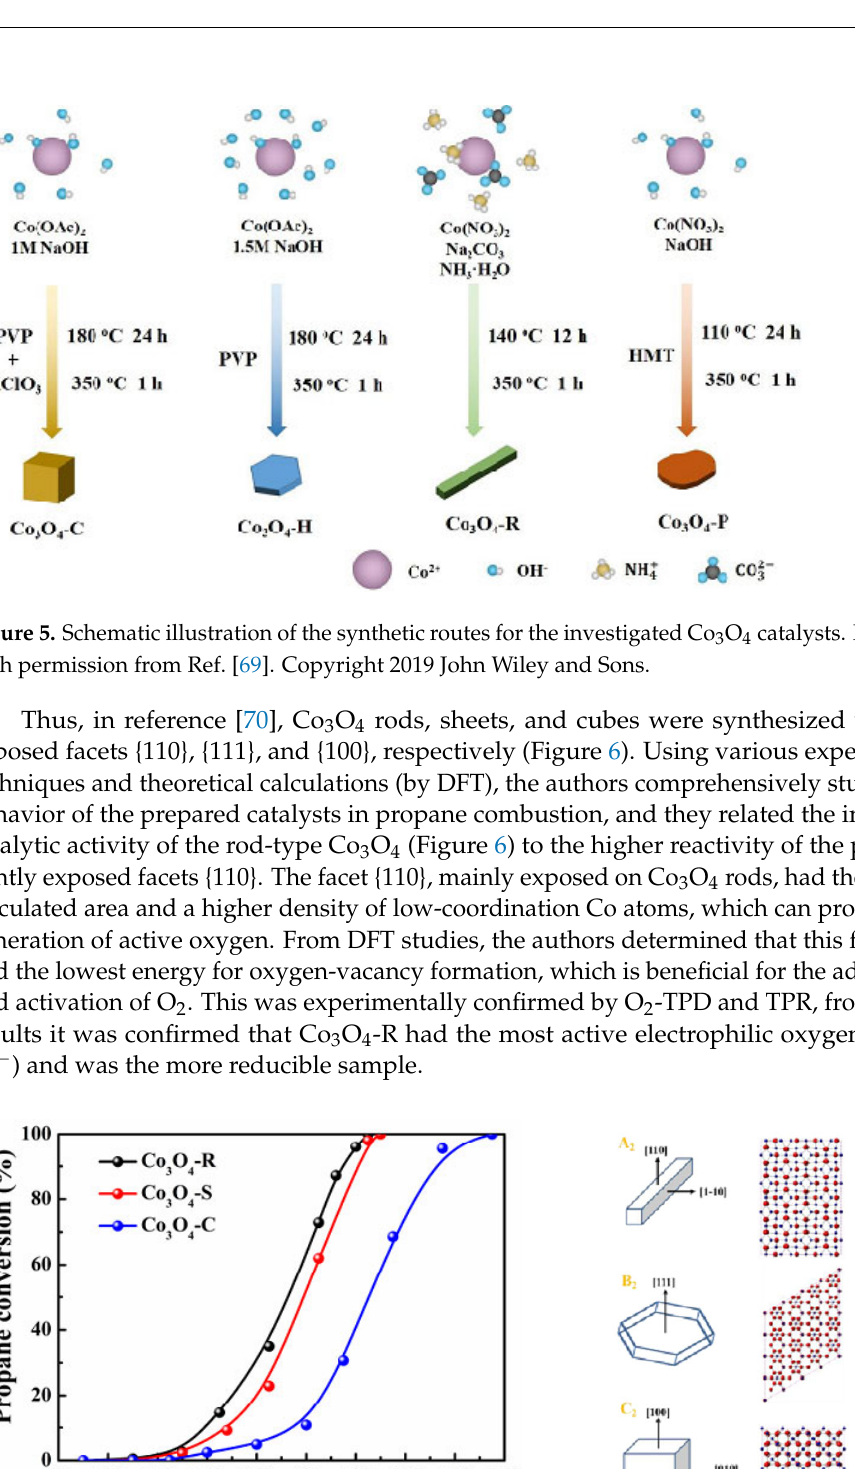
Figure 5. Schematic illustration of the synthetic routes for the investigated Co 3 O 4 catalysts. Re ‐ printed with permission from Ref. [69]. Copyright 2019 John Wiley and Sons.